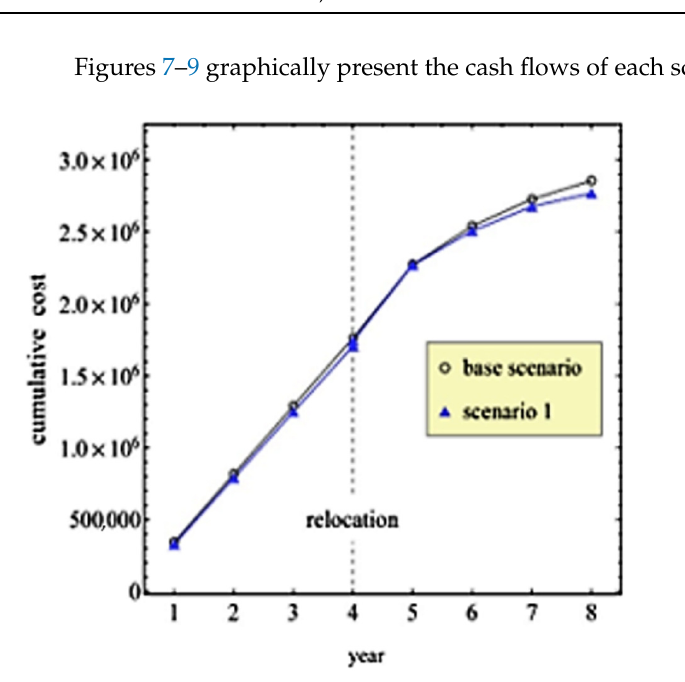
Figure 7. Comparison of cumulative costs.